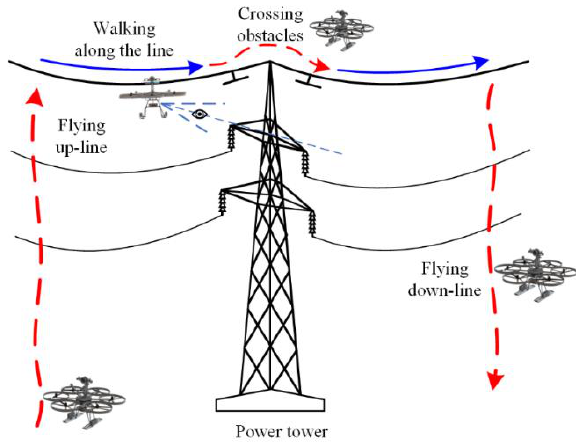
Figure 3. Illustration of inspection paths of FPTLIR.